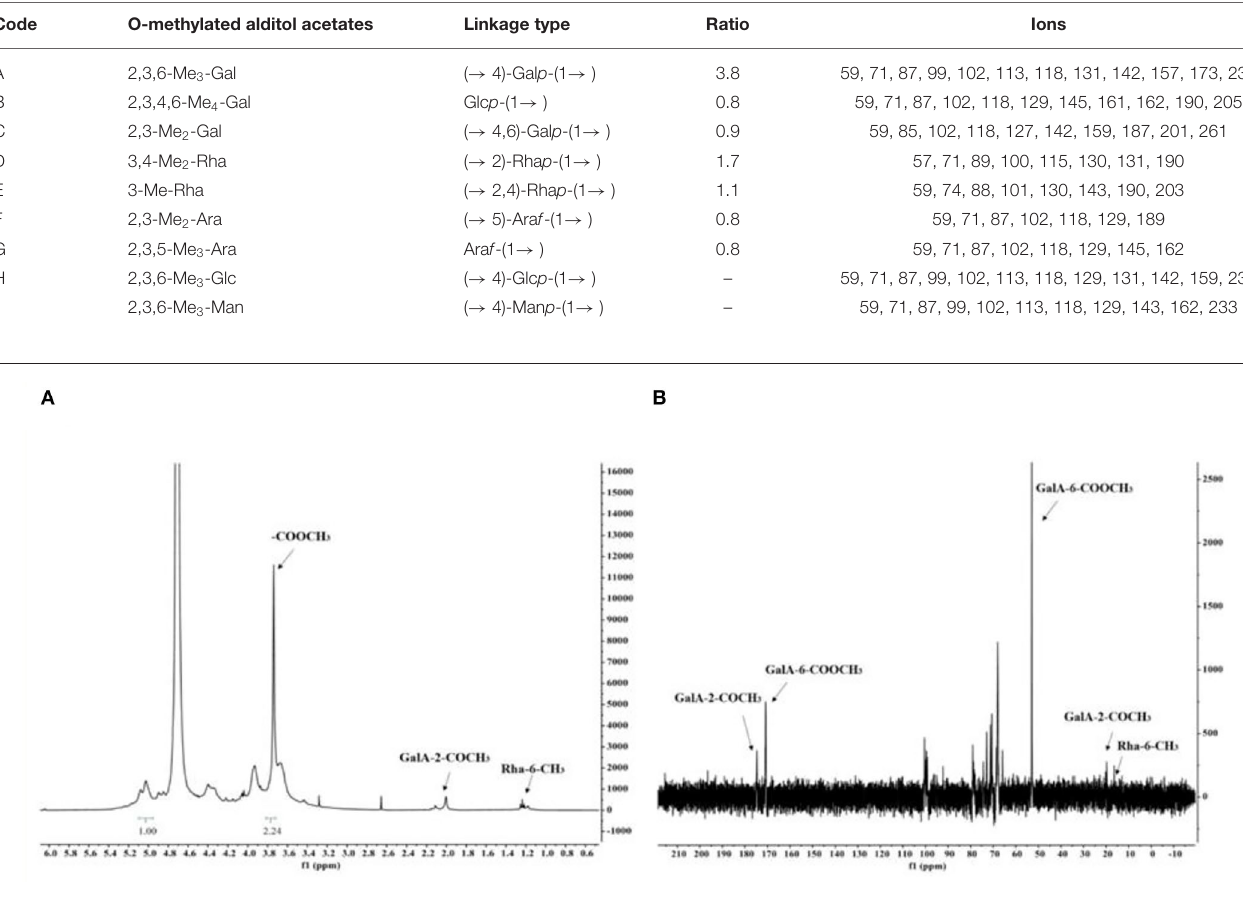
RCHP-S were methylated and part of the 2-position hydroxyl groups were acetylated. C-6 signals of residues D and E appeared in the 16.5 ppm region, which is the typical methyl signal peak for